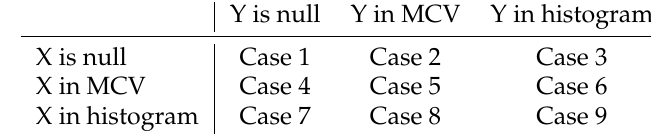
Figure 5. Nine cases for join selectivity